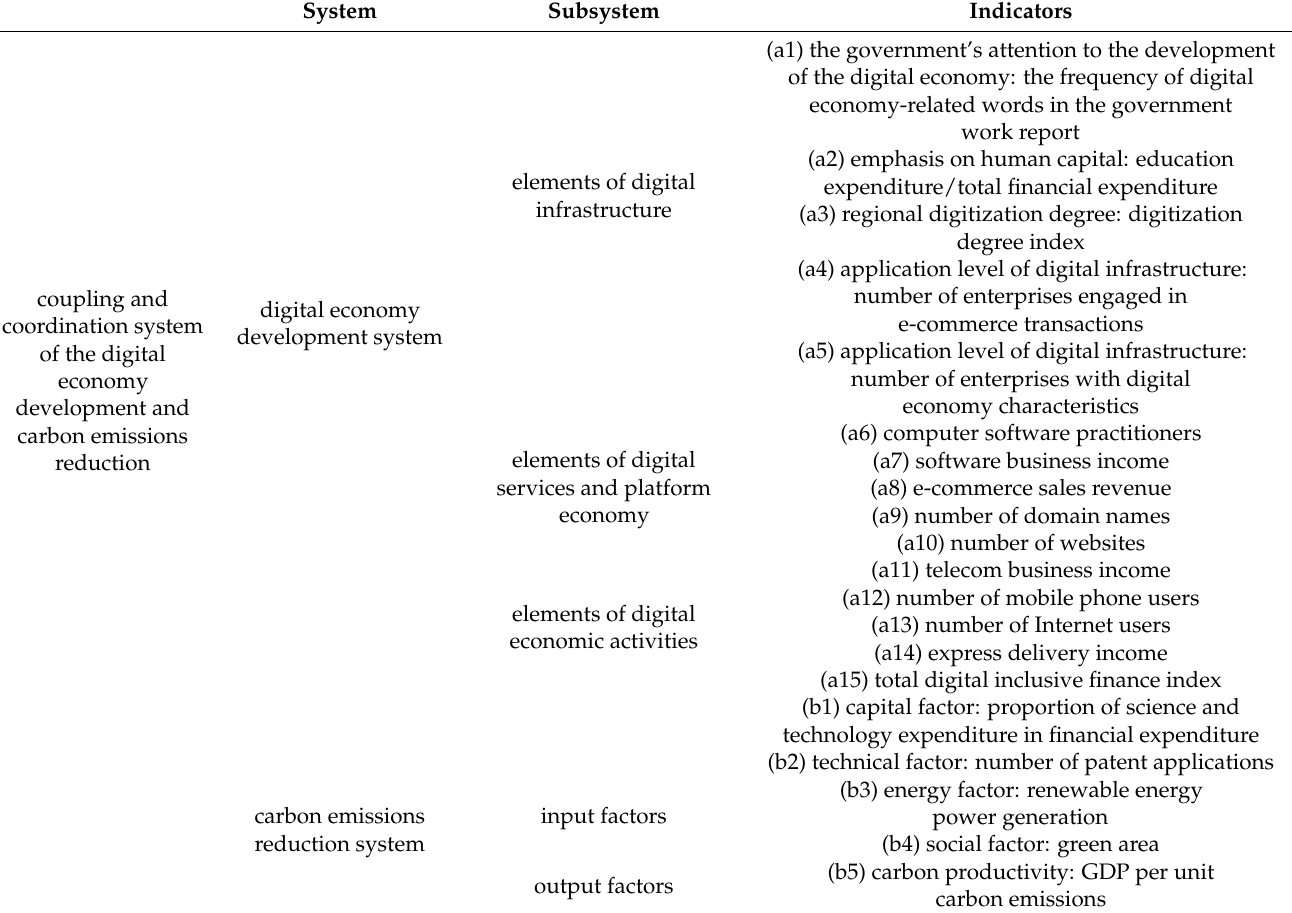
Table 1. Indicator system of digital economy system and carbon emissions reduction